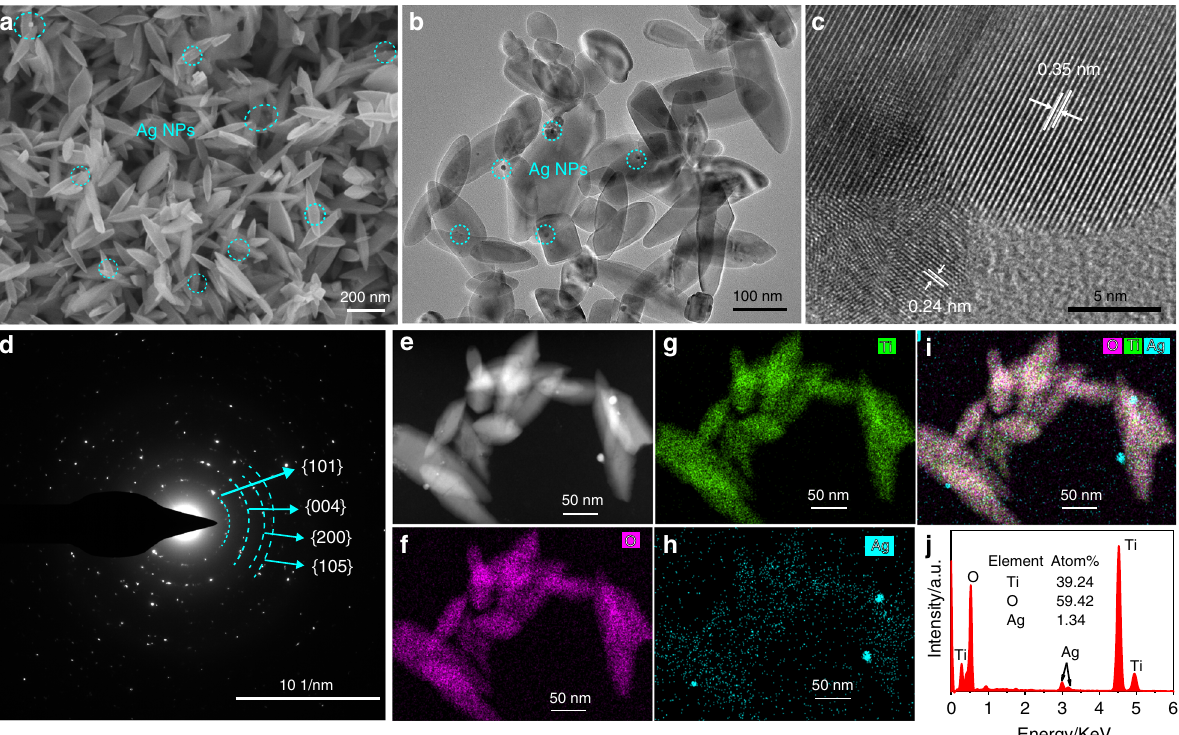
Fig. 2 Characterizations of the Ag/Ag-doped TiO 2 substrate. a SEM and b TEM images of the Ag/Ag-doped TiO 2 nanostructure prepared with 0.5 mM of AgNO 3 , Ag NPs were marked by circles; c HRTEM image of single Ag/Ag-doped TiO 2 nanostructure, showing clear lattice fringe with a spacing of 0.35 and 0.24 nm; d SAED pattern of the Ag/Ag-doped TiO 2 nanostructure, mainly exhibits the (101), (004), (200), and (105) crystal facets of the anatase phase TiO 2 . e High-angle annular dark fi eld image and local element mappings of ( f ) O, ( g ) Ti, ( h ) Ag, and ( i ) the overlay distribution of elements; ( j ) EDS